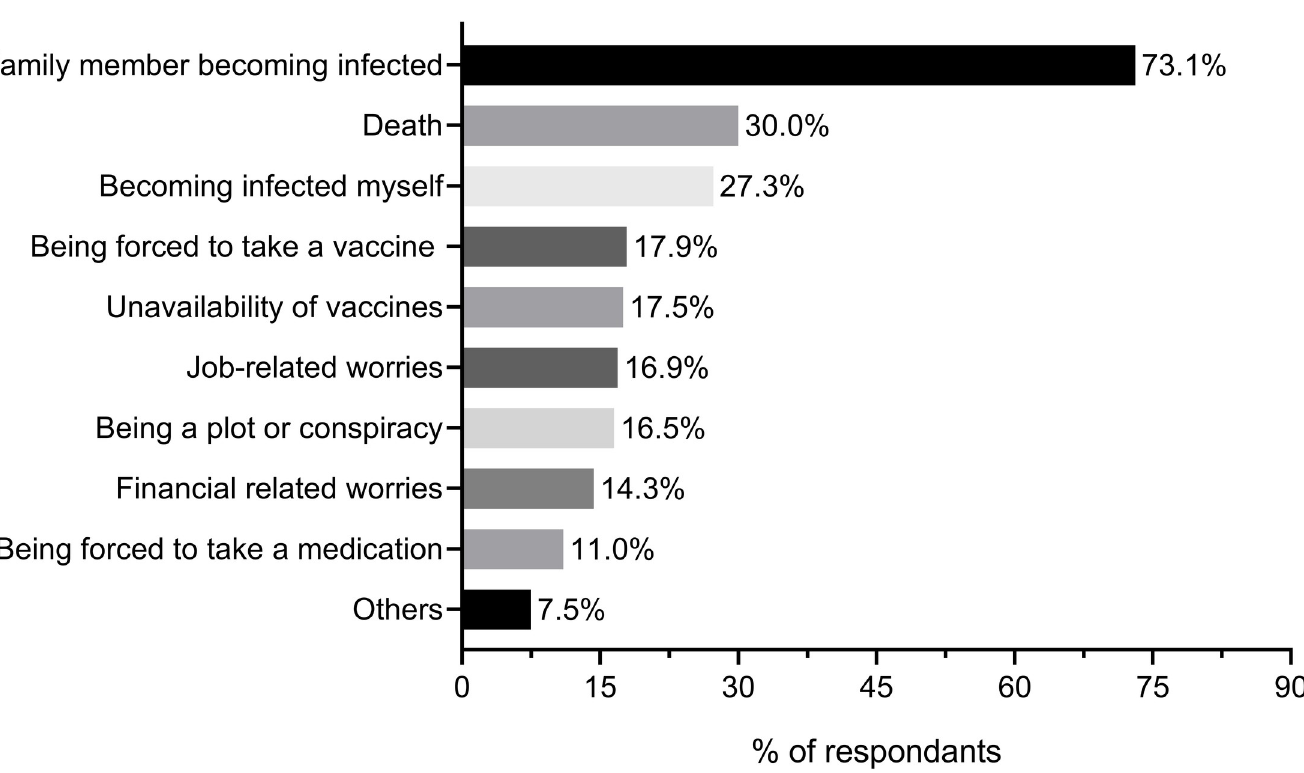
Fig 2. Jordan population worries during the COVID-19 pandemic.